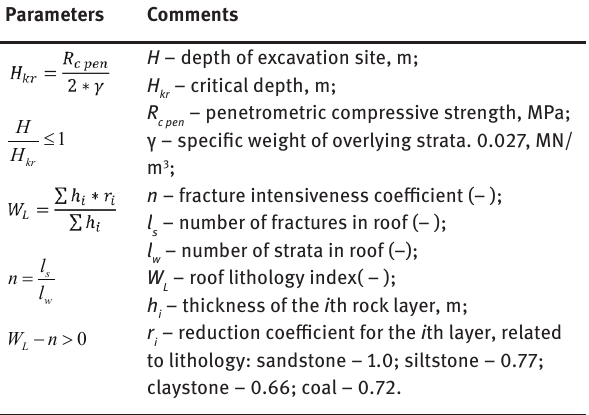
Table 2: Parameters used in the proposed methodology